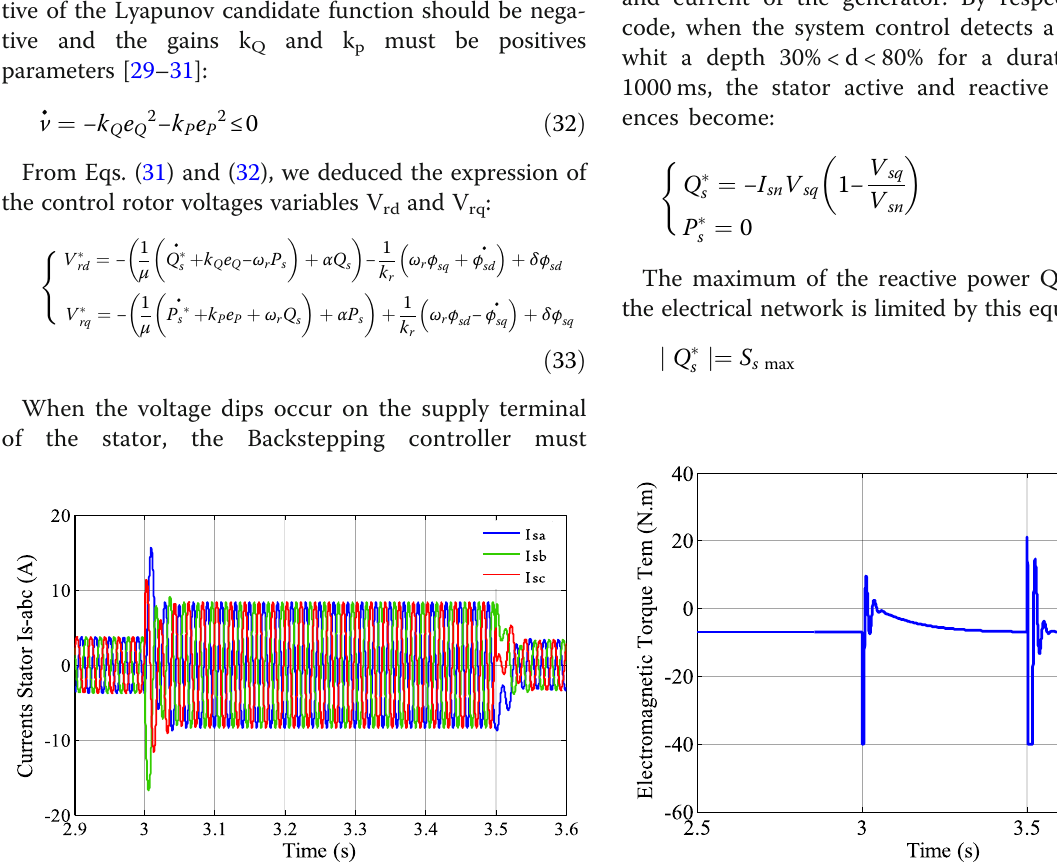
Fig. 5 Stator Currents I s-abc (A)